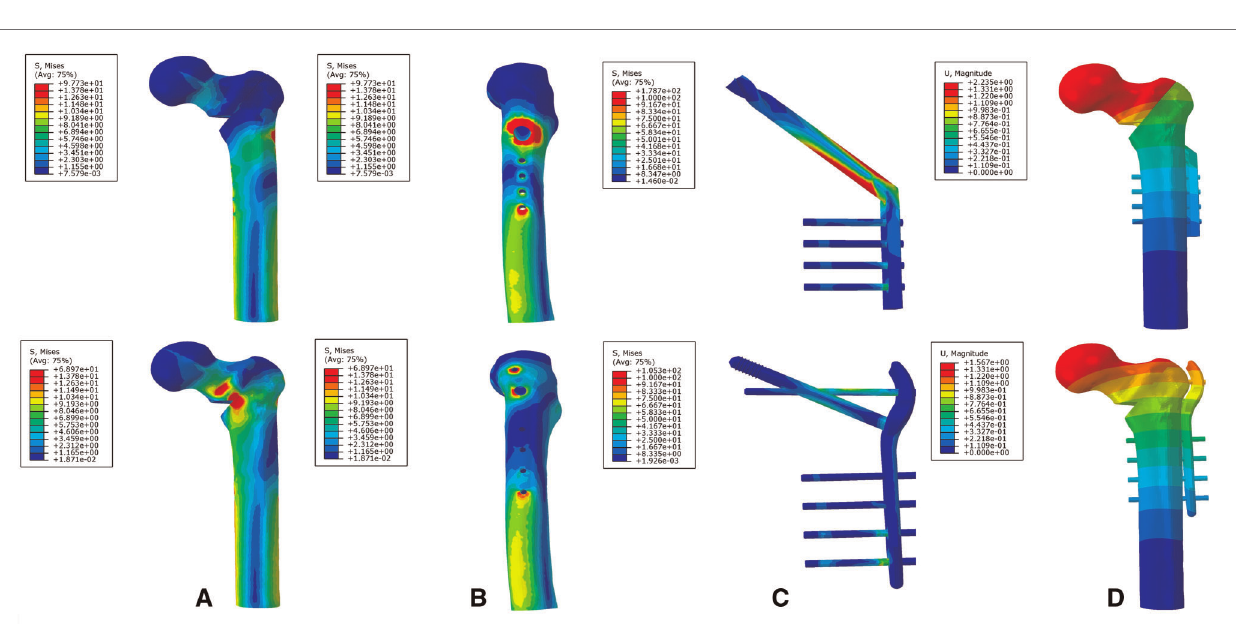
FIGURE 9 | The stress distribution and displacement distribution of two implant fi xations of an unstable intertrochanteric fracture; ( A ) the stress distribution of bone models; ( B ) the stress distribution of the lateral femoral cortex; ( C ) the stress distribution of an implant model; ( D ) the displacement distribution of three implant fi xation models. The fi gure shows that the TSFP has improved the stress distribution of the implant and bone models and increased the construct stability of the fi xation of Evans type IV intertrochanteric